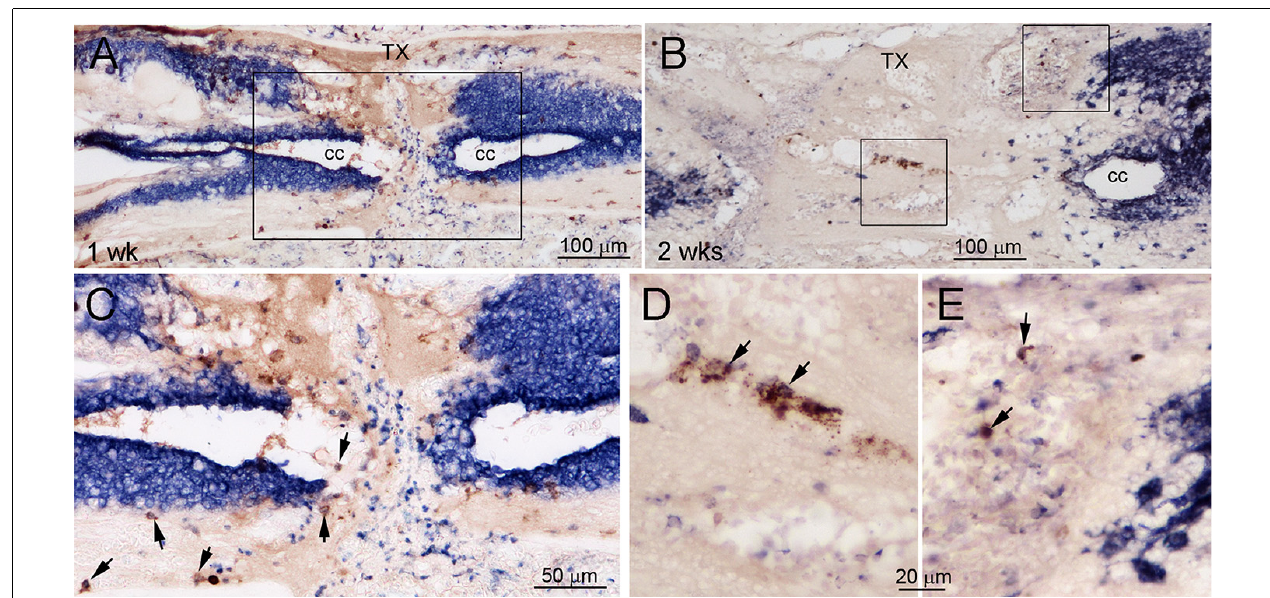
FIGURE 9 | Co-expression of lectican mRNA and a marker of microglia/macrophages. To characterize the small lectican-positive cells appearing early after TX, horizontal sections spanning the TX site were labeled colorimetrically with IB4-HRP after lectican ISH at 1 week (A,C) or 2 weeks (B,D,E) post-TX. (A) The section at 1 week from Figure 7 , Lectican D , now labeled by IB4, demonstrates that most of the small cells at the TX site that are lectican-positive by ISH do not label for IB4, most likely because they are blood cells or fibroblasts derived from surrounding tissues. (C) Enlargement of the rectangle indicated in (A) . Arrows point to doubly labeled cells. (B) A section at 2 weeks post-TX shows a reduced number of small cells positive for lecticans by ISH in the TX site and that some bind IB4. (D,E) Enlarged images of squares indicated in (B) . Arrows point to doubly labeled cells. cc = central